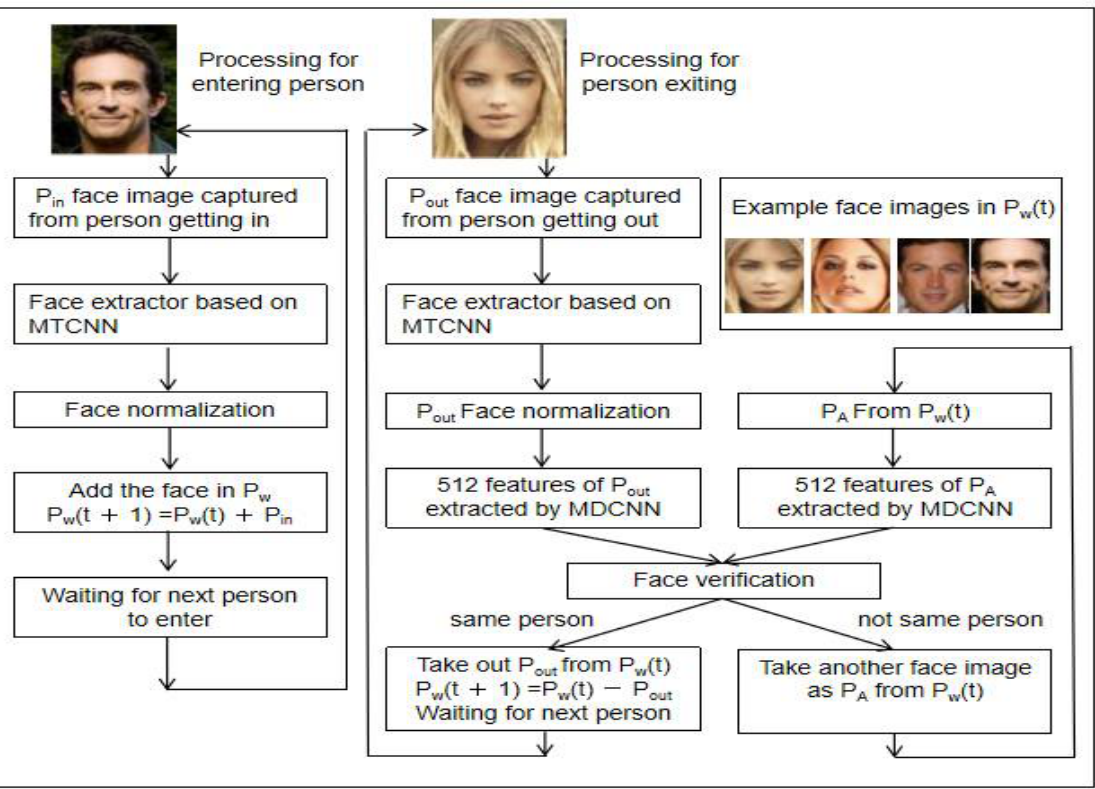
Figure 2. The gate face verification model. The MTCNN and the MDCNN are trained by different types of face images.